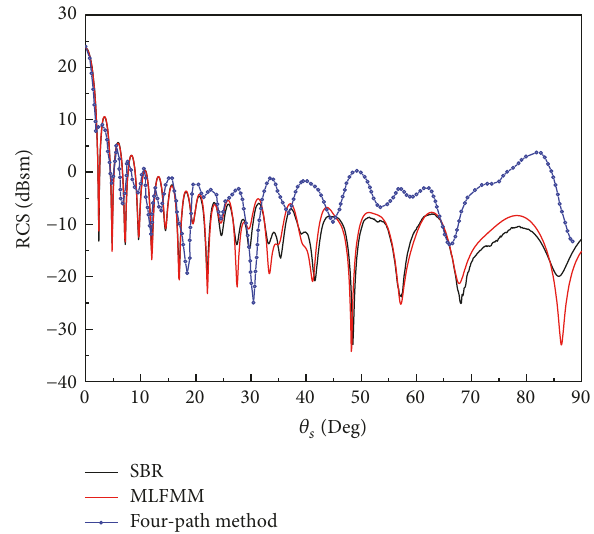
Figure 10: Monostatic RCS results for 0.03 m cube on flat